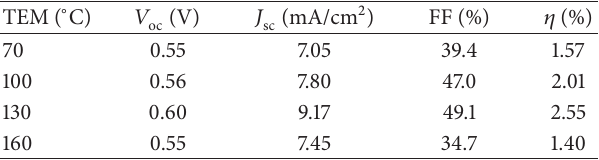
Table 2: Performances of PSCs deposited under different